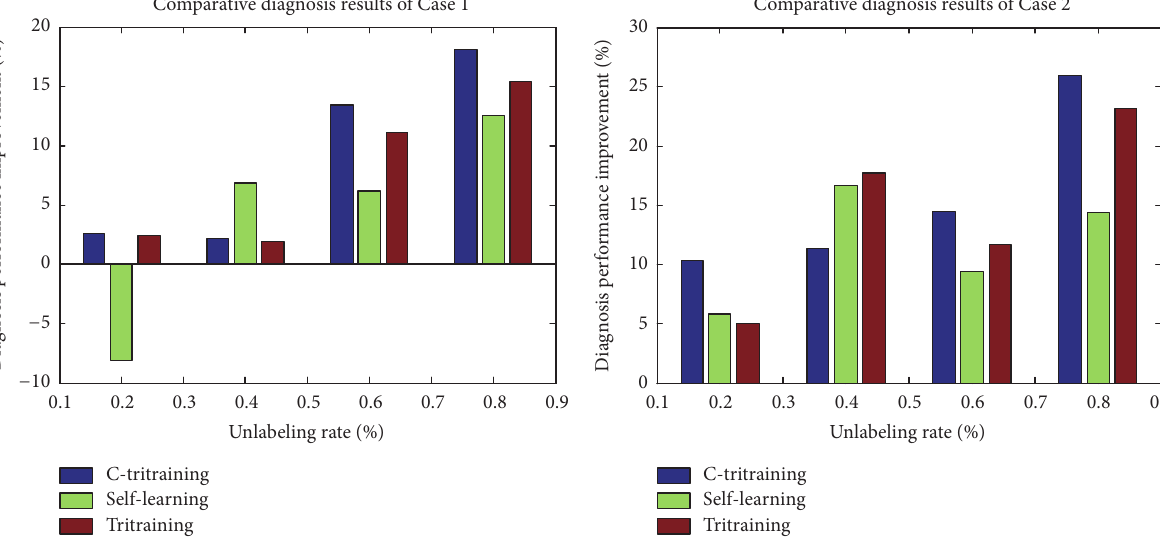
Figure 7: Performance improvement at different unlabeling rate in Cases 1 and